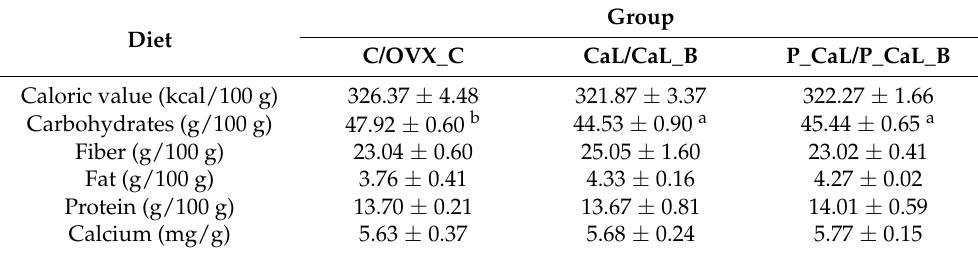
Table 1. The composition of the diets (mean and standard deviation).